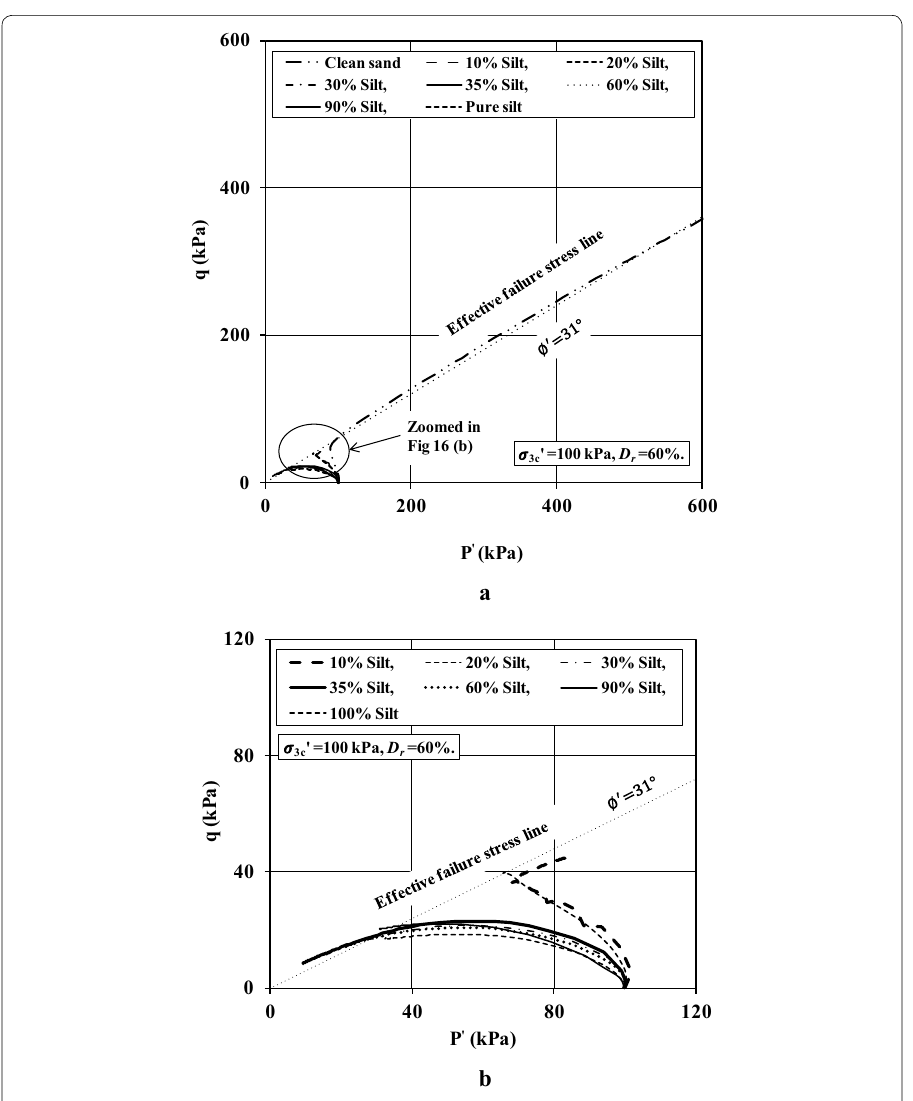
Fig. 16 Effective stress path of tested specimens at 60% initial relative density; a silt content 0–100% and b silt content 20–100%